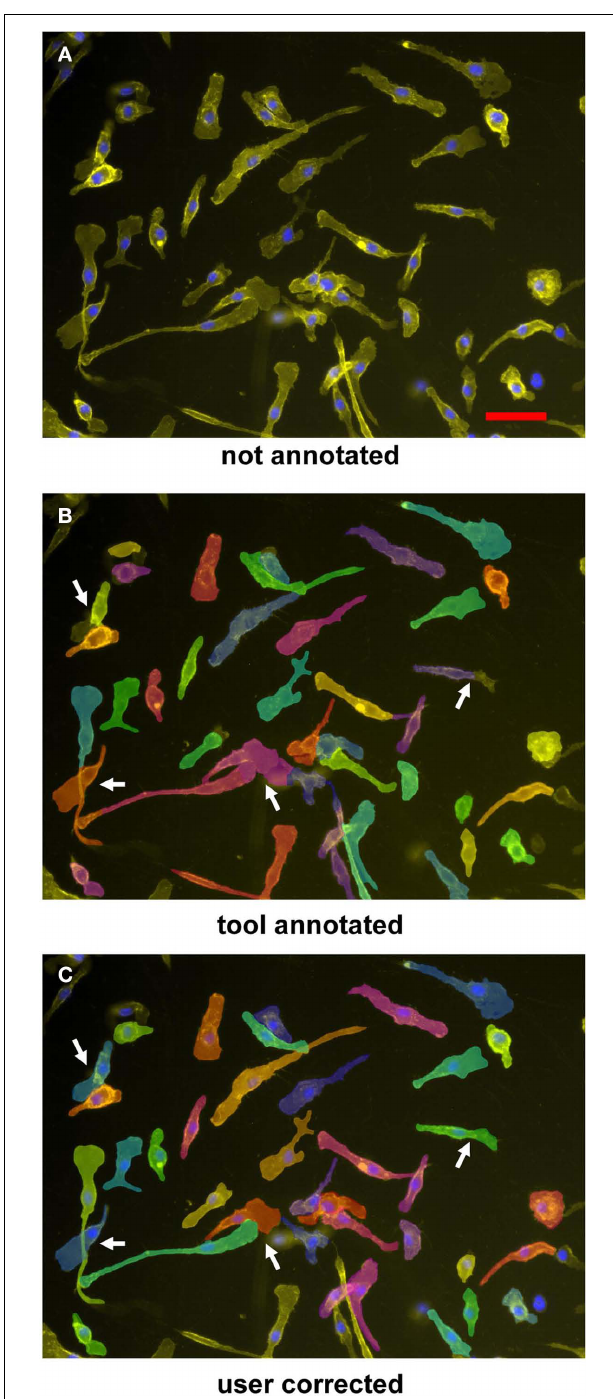
FIGURE 2 | Segmentation and annotation of macrophages with two-step segmentation software. Fluorescence microscopy images of CD11b–APC- and DAPI-stained macrophages were uploaded into the software (A) , nuclear segmentation and contact area annotation was performed by the software tool (B) , and finally checked and corrected by the user (C) . Arrowheads indicate shrinkage effects; arrows point to overlapping cells necessitating manual editing of the annotation. Cells were imaged by a 20 × objective. Scale bar represents 50 μ